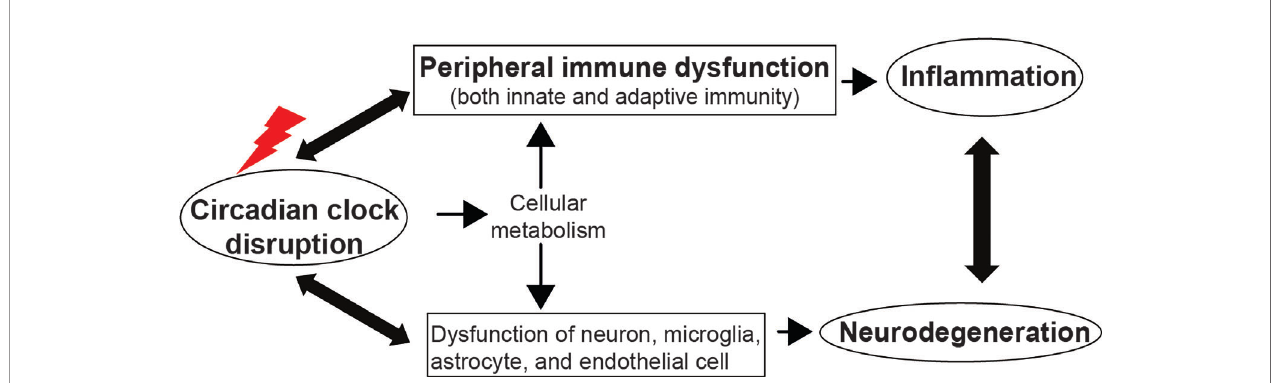
FIGURE 2 | The circadian clock regulates immune function and neurodegeneration. Disruption of the circadian clock machinery leads to immune dysfunction and neurodegeneration, which, in turn, exacerbates the circadian abnormality. The bidirectional communication between systemic in fl ammation and neurodegeneration deteriorates immune dysfunction and the progression of neurodegenerative diseases. The cellular metabolism pathway could be a mechanism underlying circadian control of immunity and